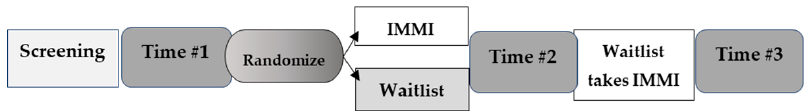
Figure 1. Study design. IMMI, Internet Mindfulness Meditation Intervention.